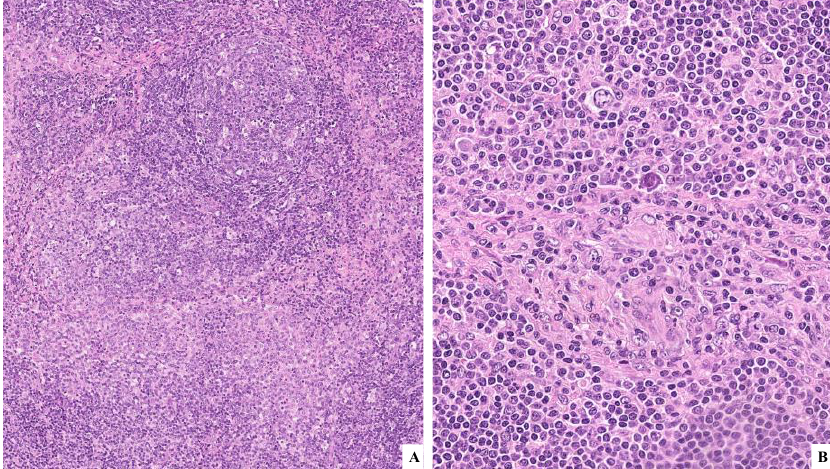
Figure 4. ( A ) H&E original magnification 10 × displaying follicular hyperplasia with polarized germinal centers and, in the perifollicular areas, aggregates of MBC. ( B ) H&E original magnification 20 × showing, in the perifollicular areas, MBC mixed with rare large mononucleated or binucleated cells containing an eosinophilic nucleolus and basophilic cytoplasm.